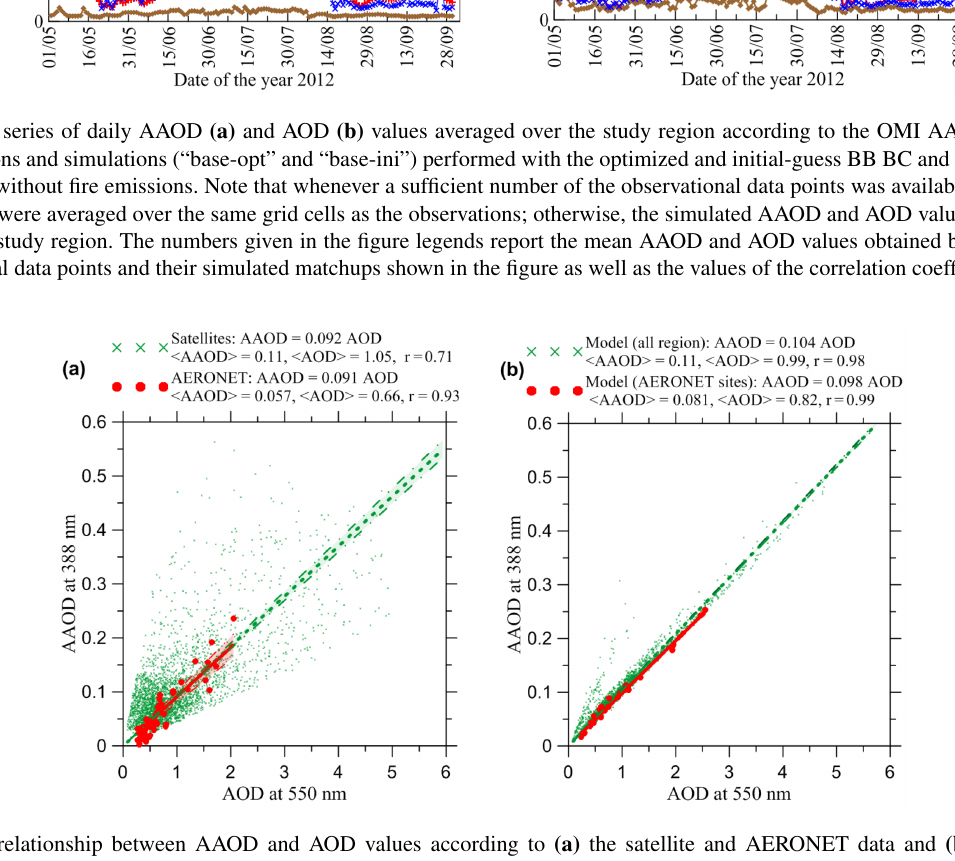
Figure 7. The relationship between AAOD and AOD values according to (a) the satellite and AERONET data and (b) corresponding simulated data from the “base-opt” model run. In the case of the satellite data, each data point represents a value of AAOD or AOD for a given cell of the model grid. The AERONET data are described in Sect. 2.1.4; the corresponding modeled data were extracted for grid cells and days matching the AERONET observations. The figure legends report the equations of a linear regression without an intercept, the mean values of the AAOD and AOD for the different datasets, and the values of the correlation coefficient for each